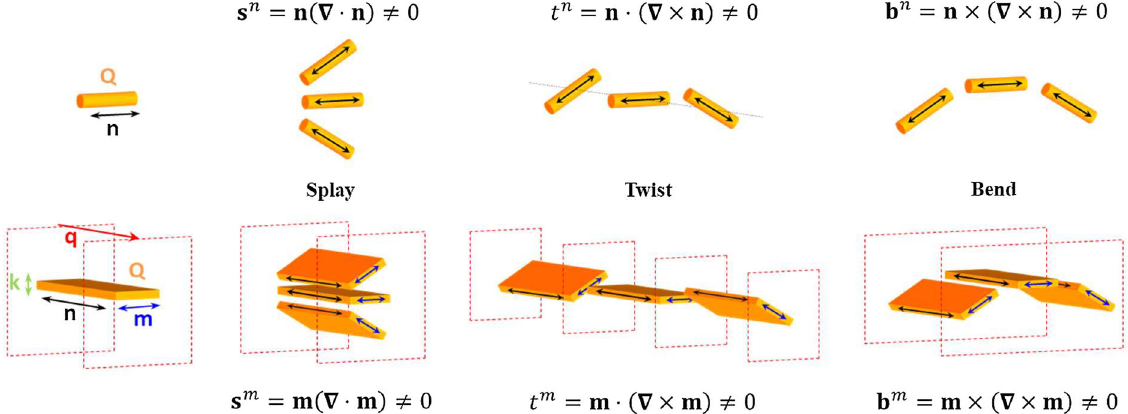
9. Schematic representation of the nematic directors ( n , m , and k ), the order parameter tensor ( Q ), and the main distortion modes in the N and Sm A phases. In the uniaxial N phase (top row), the only relevant distortions are those of the main director n . In the Sm A b phase (bottom row) and at fixed structure of the smectic layers (shown in red), the only relevant distortions are those of the secondary director m